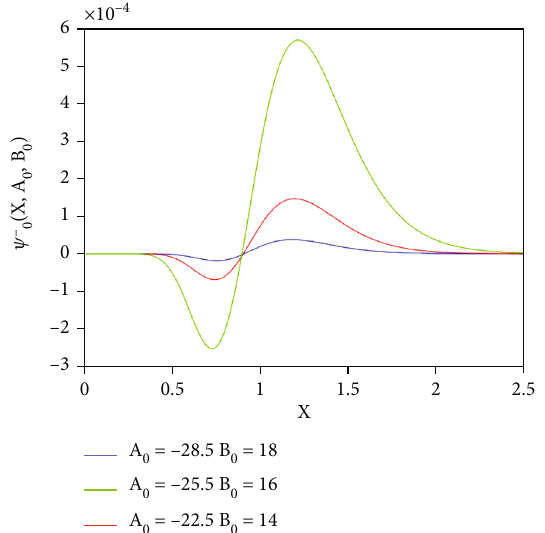
ð x , A Þ , B 0 0 1